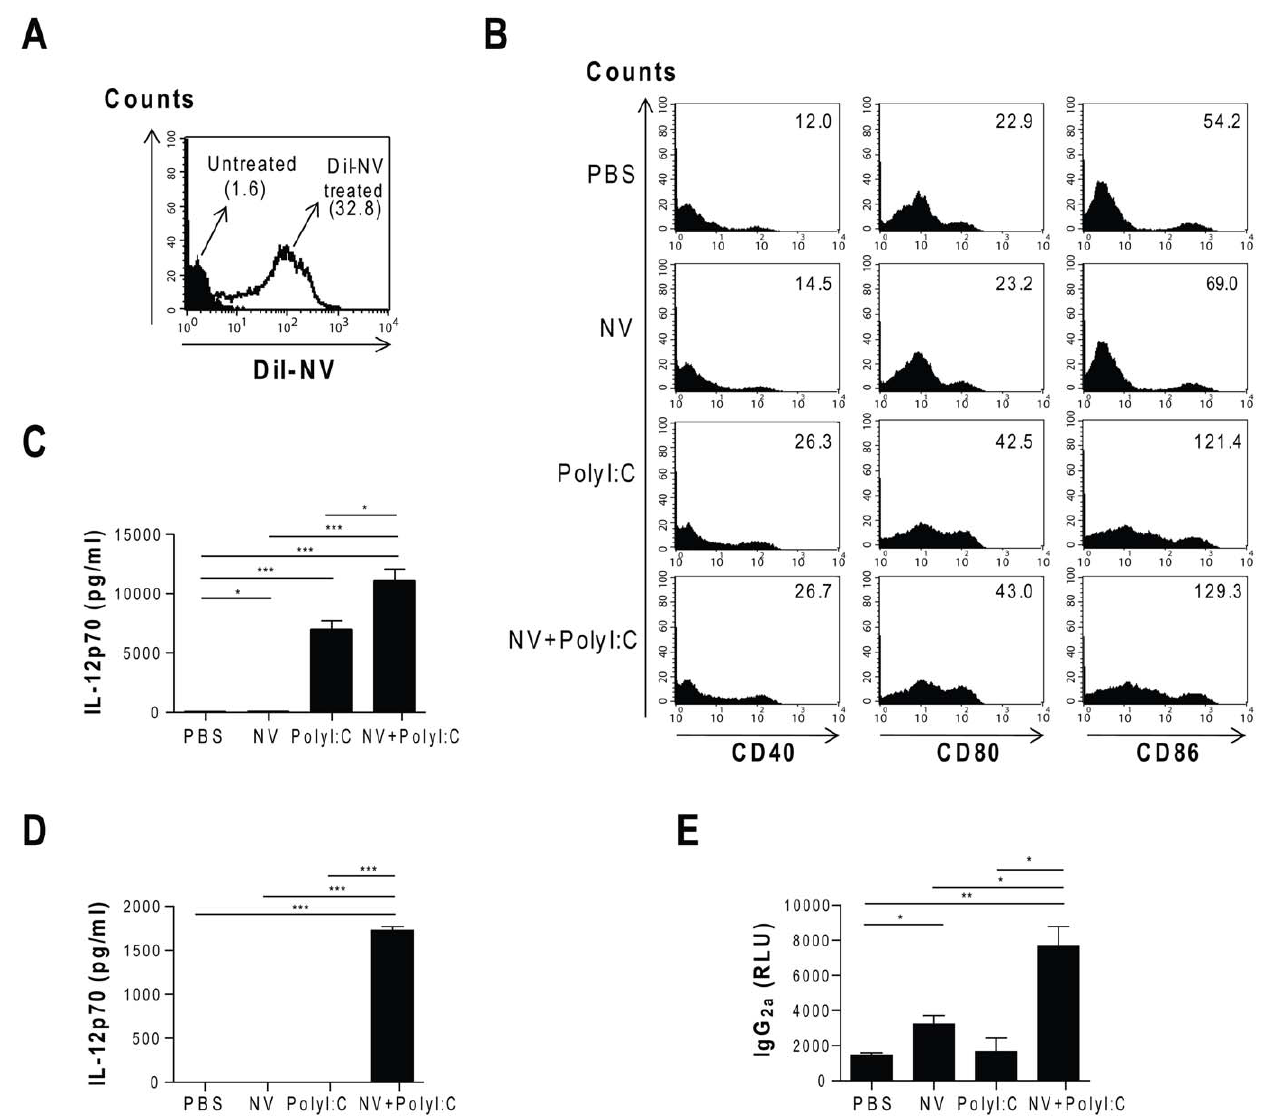
Figure 3. Immune responses induced by tumor-derived NVs. A. C57BL/6 mouse-derived bone marrow DCs efficiently take up DiI-labeled NVs (10 m g/ml), as assessed by FACS analysis. The numbers indicate mean fluorescence intensities. B. FACS analysis reveals that DCs upregulate the expression of maturation markers CD40, CD80, and CD86 after 24 h of incubation with NVs (2 m g/ml) and polyI:C (10 m g/ml). The numbers in the panels indicate mean fluorescence intensities. C. IL-12p70 levels in the supernatants of the cultured DCs, as assessed by ELISA. D. Splenocytes were collected from the mice immunized with NVs (10 m g) and/or polyI:C (50 m g), and the levels of secreted IL-12p70 were determined after in vitro re- stimulation with NVs. E. Serum samples were collected and analyzed by ELISA for the presence of anti-tumor IgG 2a . * P , 0.05; ** P , 0.01; *** P ,